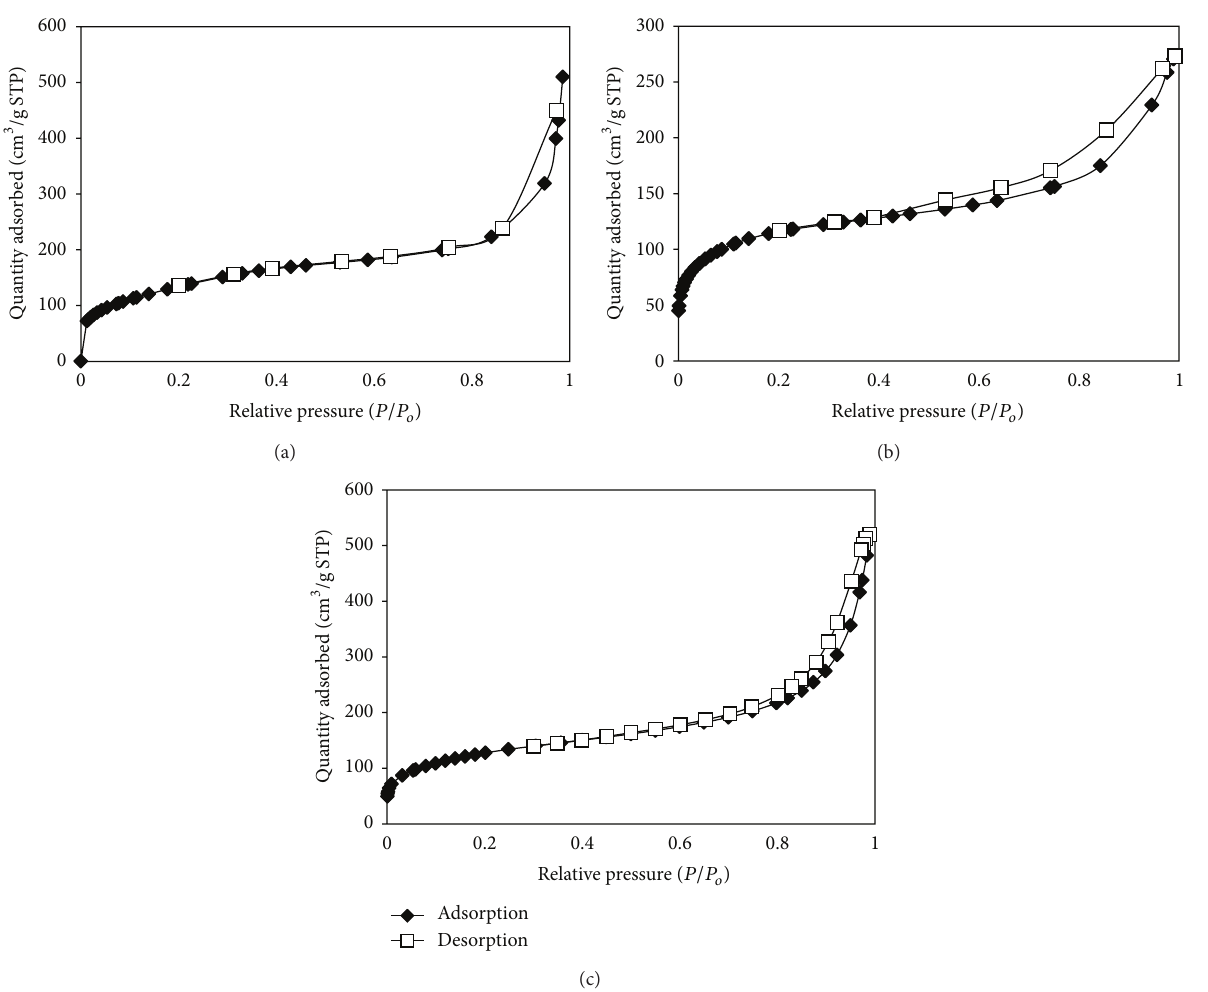
Figure 1: N 2 adsorption-desorption isotherms at 77K: (a) Fe-PPH (exc), (b) FeSO 3 -PPH (exc), and (c) PPH-Fe (imp). performed using a Jasco V-530 spectrophotometer. Na 2 SO 3 was used to quench the oxidation before the